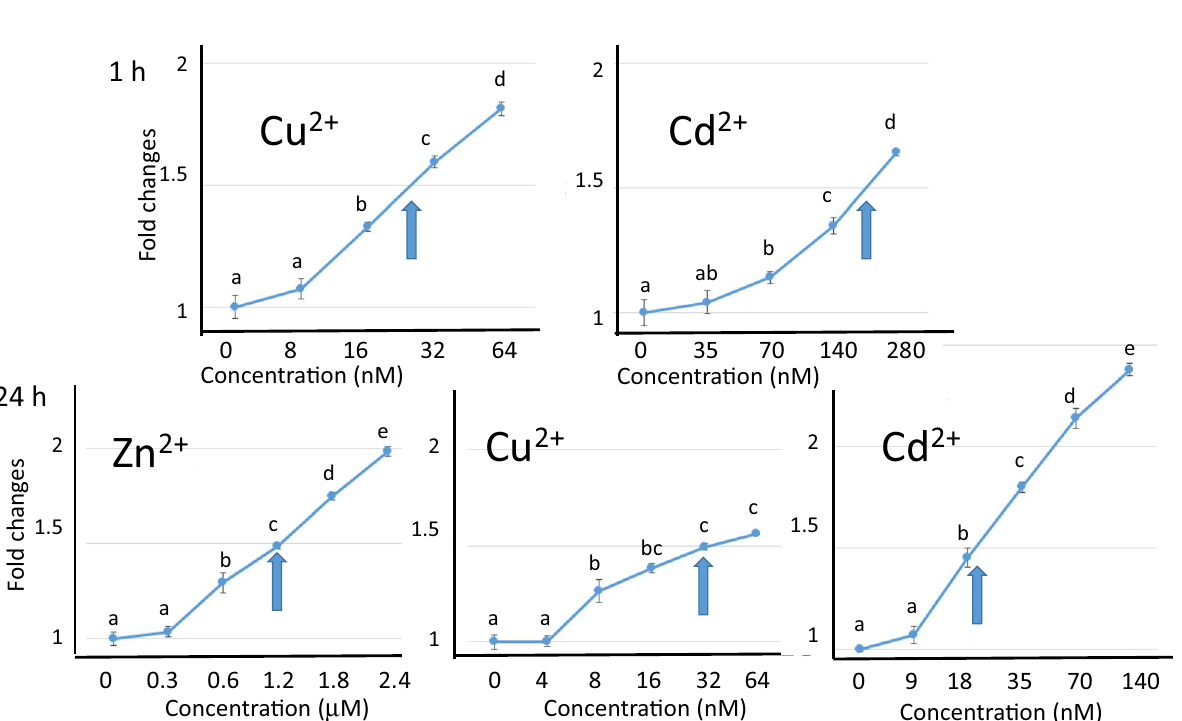
Figure 5. Dose depenent GFP expression changes after heavy metal exposure for 1 h or 24 h. Five daphniids were exposed in 10 mL of ADaM containing indicated metal ions for 1 h or 24 h. GFP expression was quantified and normalized to the control (0 µg/L) expression level. Numbers on x-axis indicate concentrations of each heavy metal (µM for Zn 2+ and nM for Cu 2+ and Cd 2+ ). Y-axis indicates fold changes. Arrows indicate EC IR1.5 values. Top: 1 h exposure, Bottom: 24 h exposure. N = 5; *** p < 0.001; ** p < 0.01; * p < 0.05